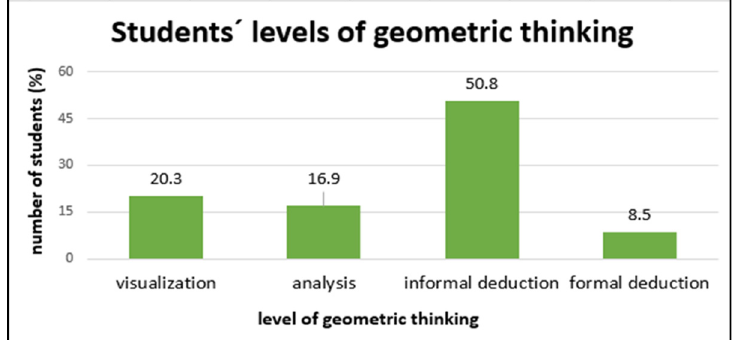
Figure 2. Students´ levels of geometric thinking according to the van Hiele theory. Figure 2. Students’ levels of geometric thinking according to the van Hiele